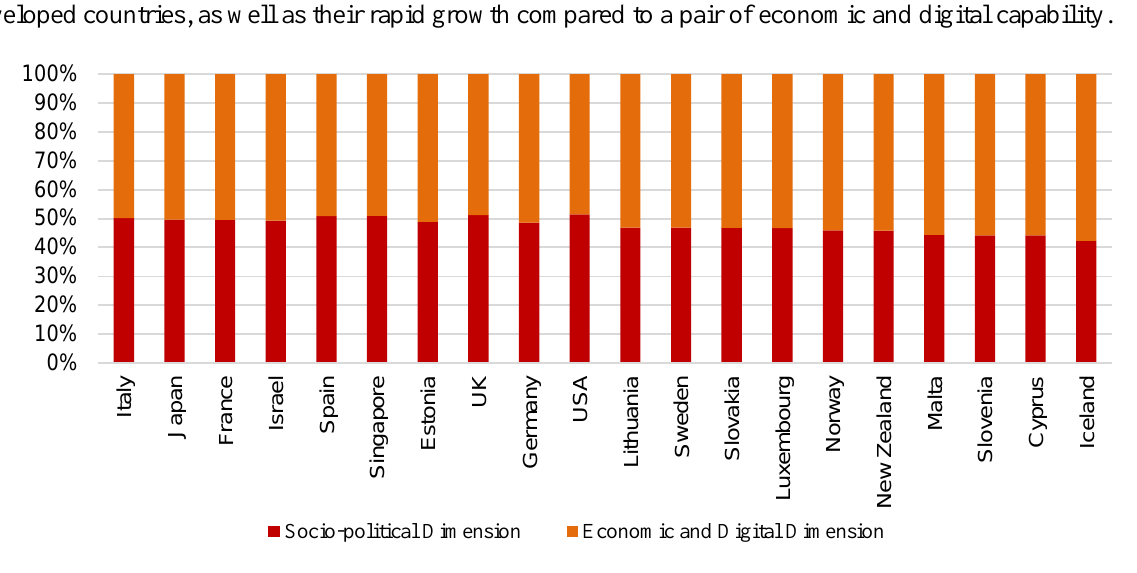
Figure 6. Balancing composite target pairs of economic, social, political, and digital capability and cyber security dimensions for developed countries. Source: Authors’ calculations